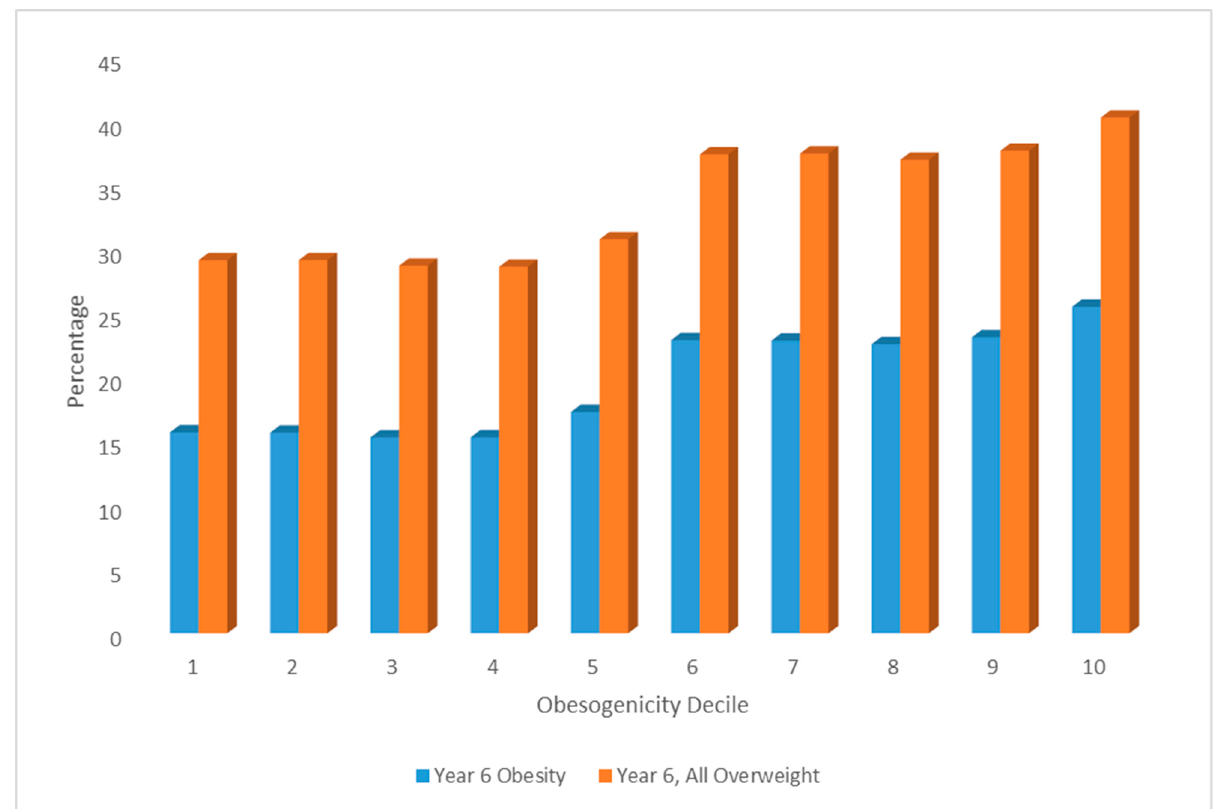
Figure 3. Child Obesity and Overweight according to Obesogenicity Decile. Table 5. Obesogenic Environment Score and Urban-Rural Context. Binary Indicators Measurement